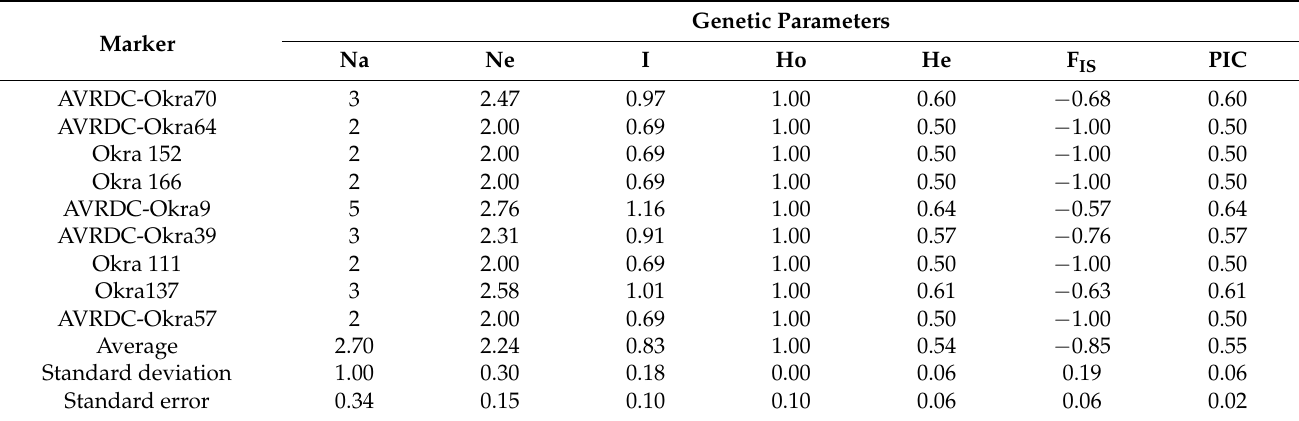
Table 3. Genetic diversity parameters generated by SSR markers among 26 okra